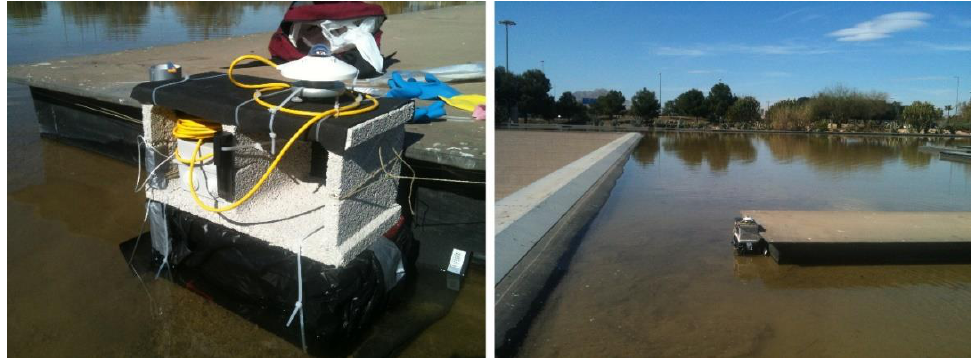
Figure 6. Installation of the pyranometer and sensors on the water-covered roof of the MUA.